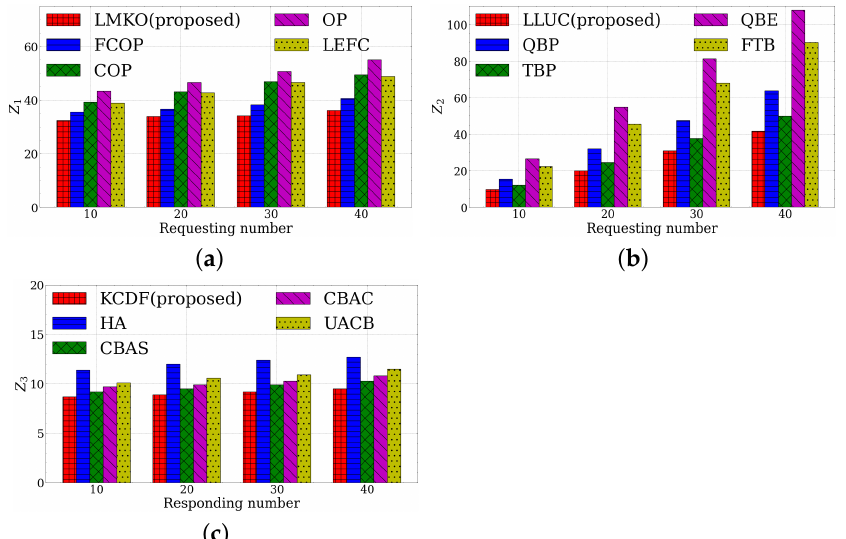
Figure 4. Performances under different module baselines. ( a ) LMKO baselines. ( b ) LLUC baselines. ( c ) KCDF